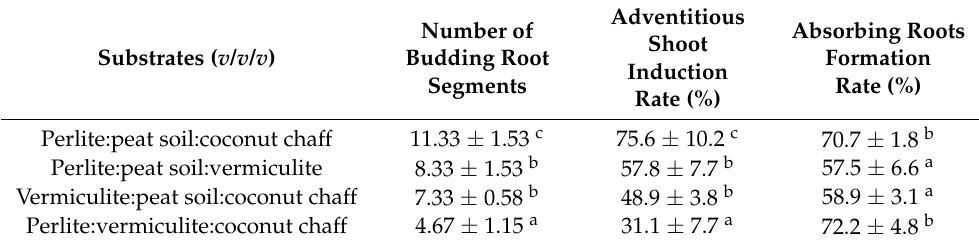
Table 7. Effects of different substrates on adventitious shoot induction